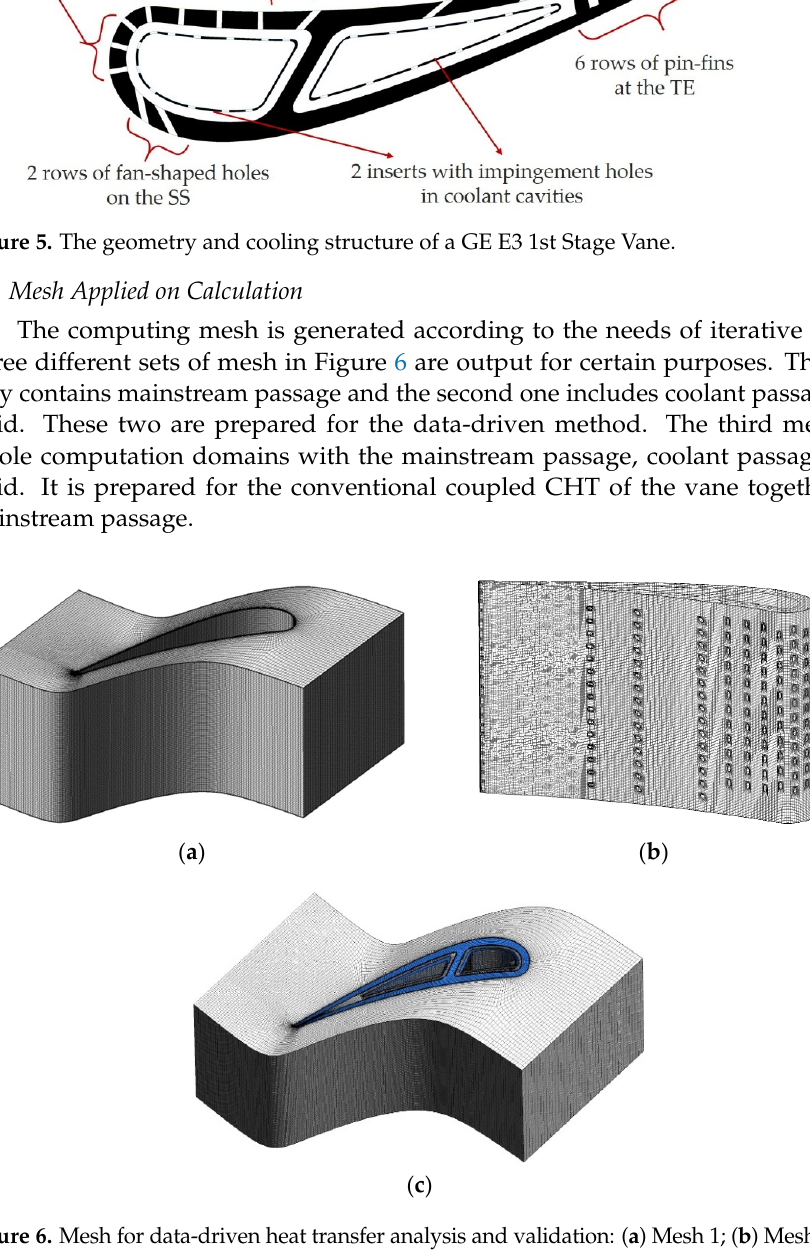
Table 2. Grid independence test. Grid